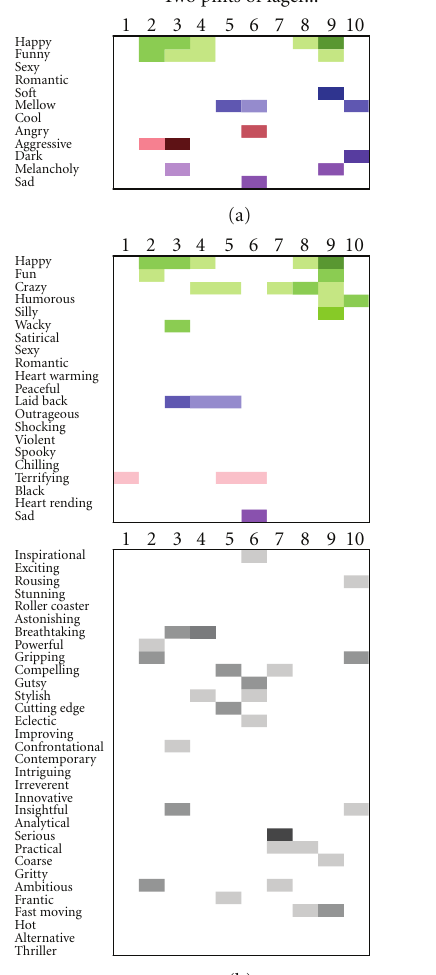
Figure 11: LSA correlation values of 10 episodes of (a) “Two Pints of lager” against 12 last.fm tags, and (b) 53 tva atmosphere terms.